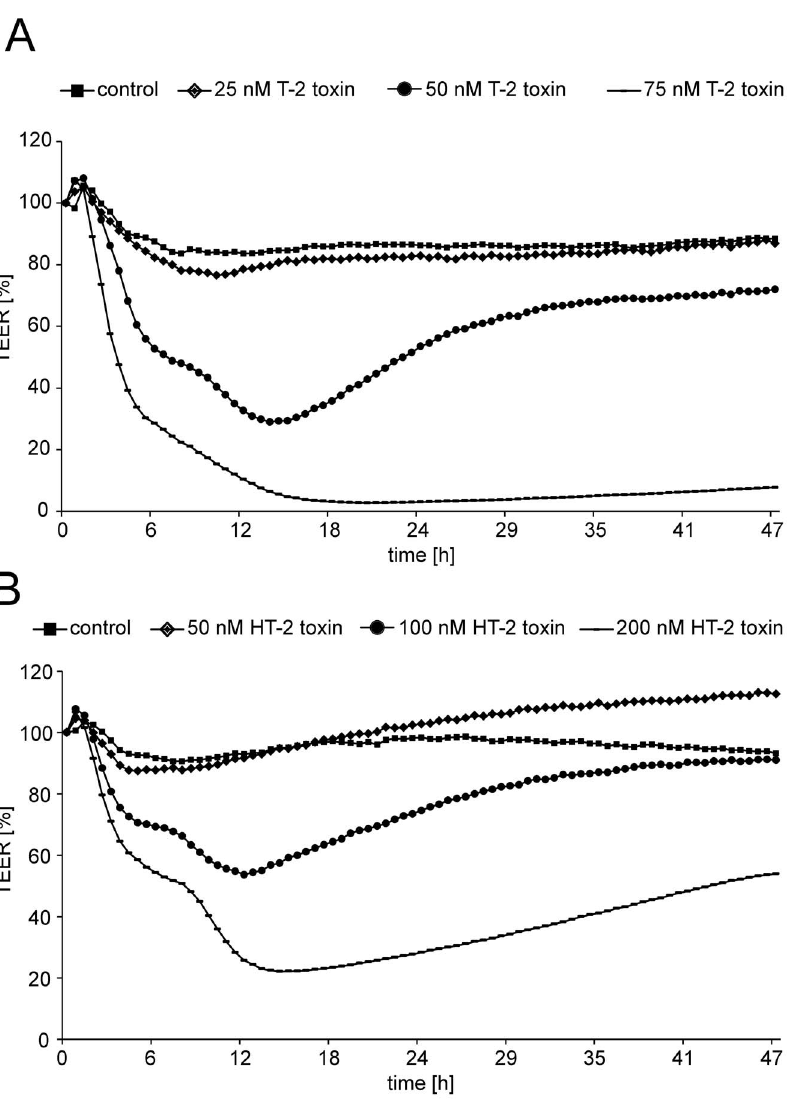
Figure 3. Effects of T-2 and HT-2 toxin on barrier function of PBCEC over 48 h. A: TEER measurements after incubation of various concentrations of T-2 toxin from the apical side to PBCEC monolayers. B: Results of TEER measurements after incubation of different HT-2 toxin concentrations from the apical side to PBCEC monolayers. all: n=9 with standard deviations 10 – 15% (not shown).